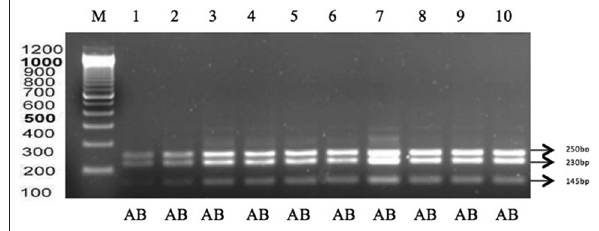
from polymerase chain reaction-restriction fragment length polymorphism using AluI retraction enzymes in the Madrasin cattle follicle-stimulating hormone gene. Lane M: Marker, lanes 1-14 (250 bp, 230 bp, and 145